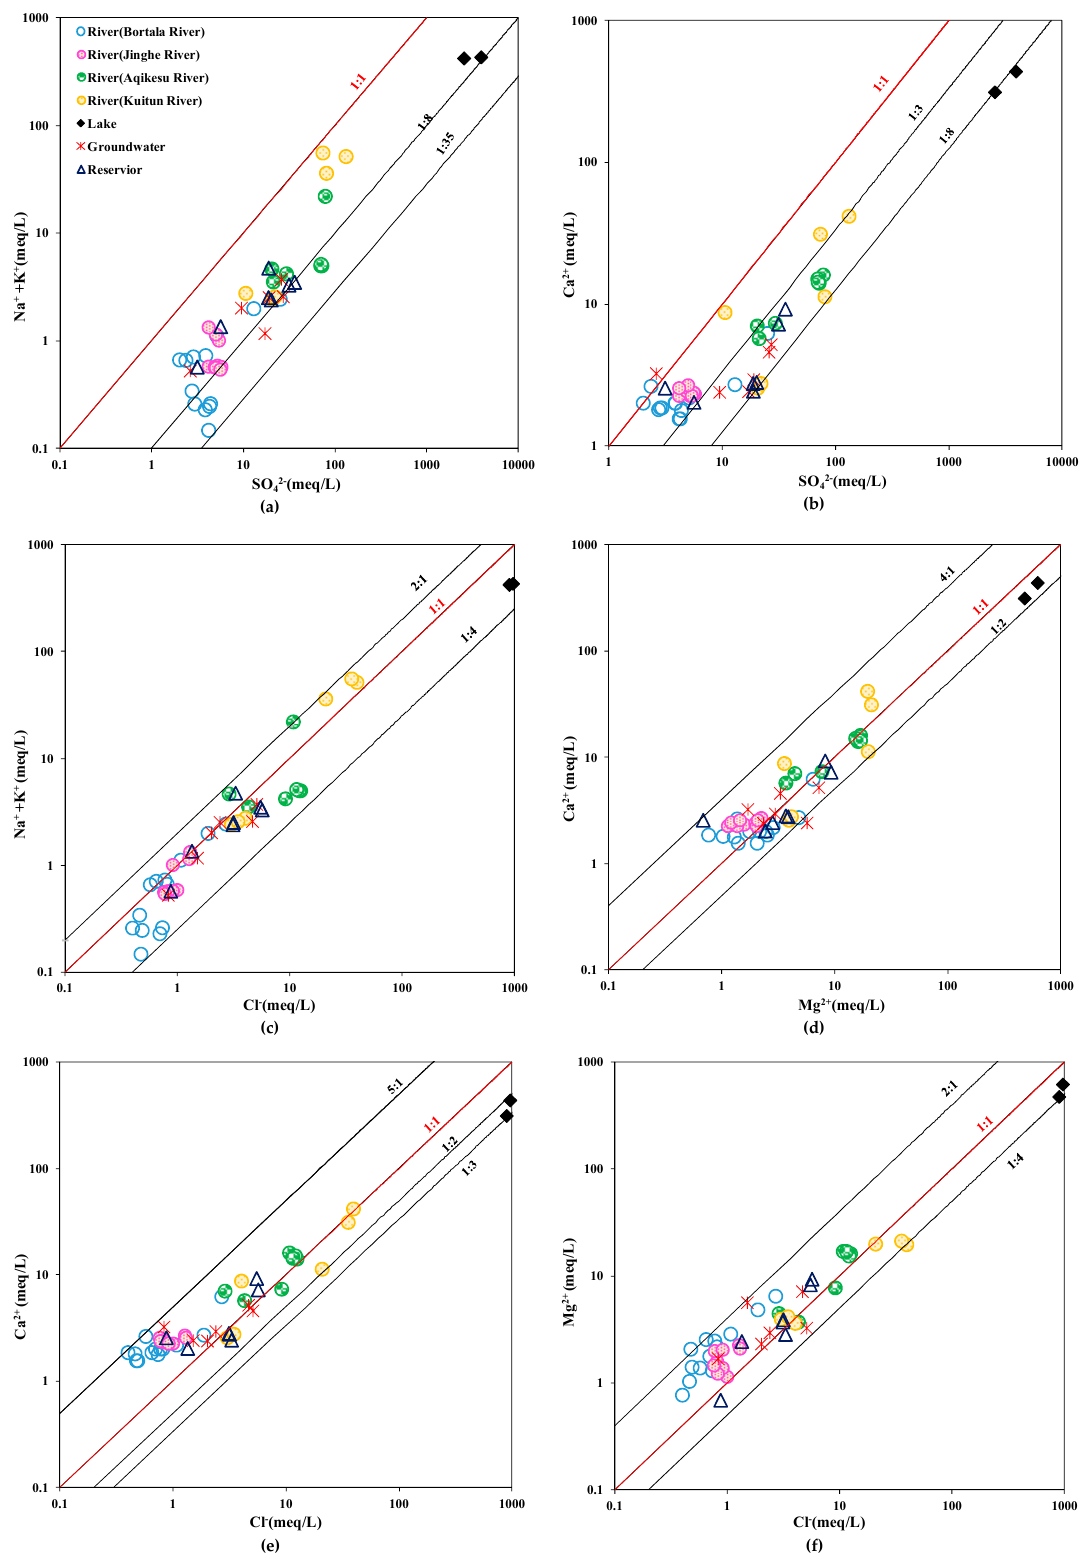
Figure 7. Distributions of ionic ratios in water samples: ( a ) Na + + K + versus SO 42 − ; ( b ) Ca 2+ versus SO4 2 − ; ( c ) Na + + K + versus Cl − ; ( d ) Ca 2+ versus Mg 2+ ; ( e ) Ca 2+ versus Cl − ; ( f ) Mg 2+ versus Cl − .